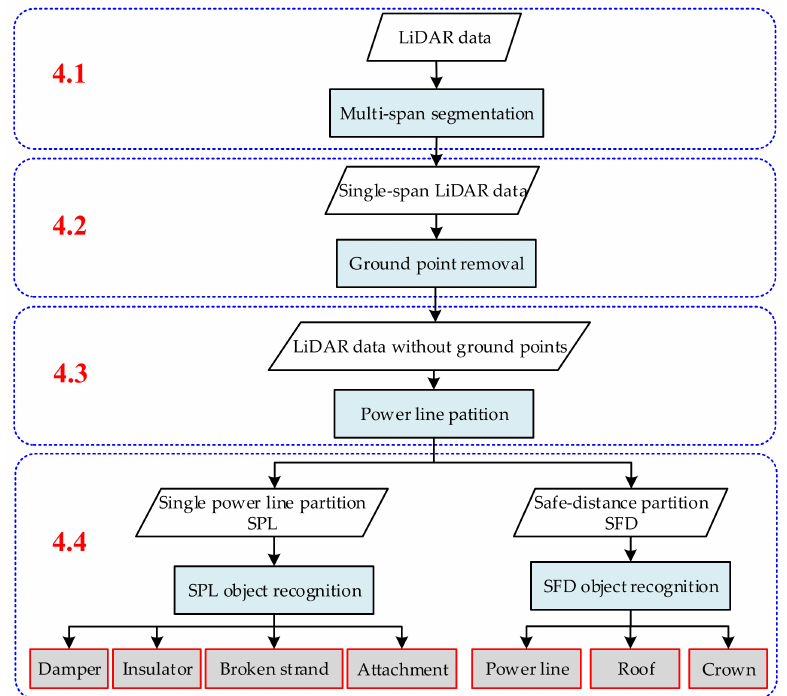
Figure 4. Flowchart of the entire